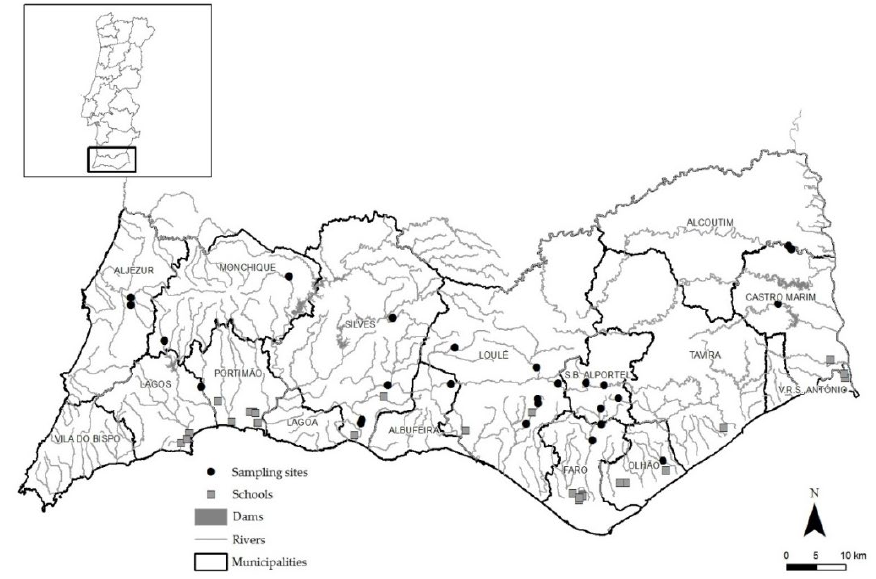
Figure 2. Geographical distribution of the sampling sites complemented with the location of the secondary schools involved in the study. Dams and municipality boundaries are also depicted.